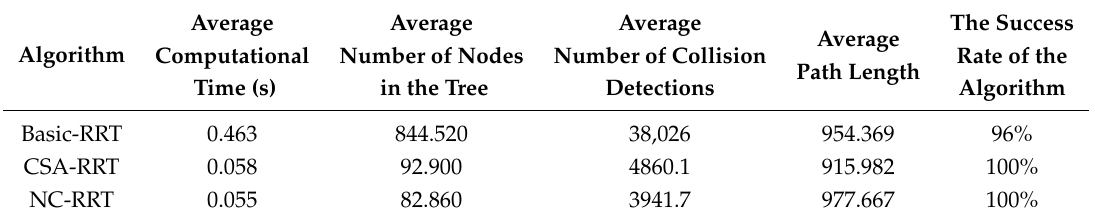
Table 1. Simulation results of the three algorithms in the cluttered environment. ( k = 1, c = 2 ) .